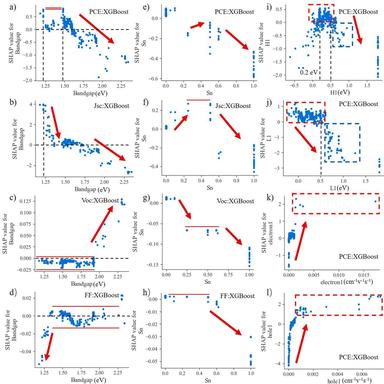
The effect of a single feature on the model decision. the Y-axis represents how the SHAP value (contribution) of a feature changes with the true value of the feature. a)-d) The contribution of the bandgap to the model PCE:XGBoost, Jsc:XGBoost, Voc:XGBoost and FF:XGBoost decision. e)-h) The contribution of the Sn content to the model PCE:XGBoost, Jsc:XGBoost, Voc:XGBoost and FF:XGBoost decision. i)-j) The contribution of the transport barrier feature (H1, L1) to the model PCE:XGBoost decision. k)-l) The cont